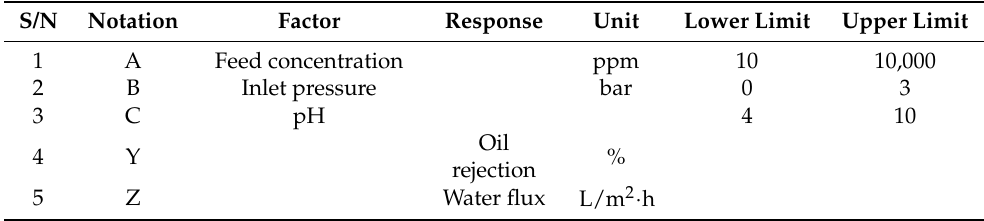
Table 1. Notation of the factor, levels of independent variables, and responses of the dependent variable in the experimental design.